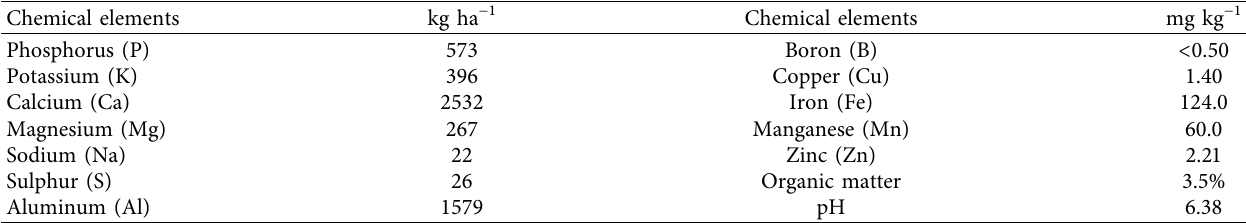
Table 1: Soil chemical elements, organic matter, and pH of the experimental site at 0–15cm before planting. Chemical elements